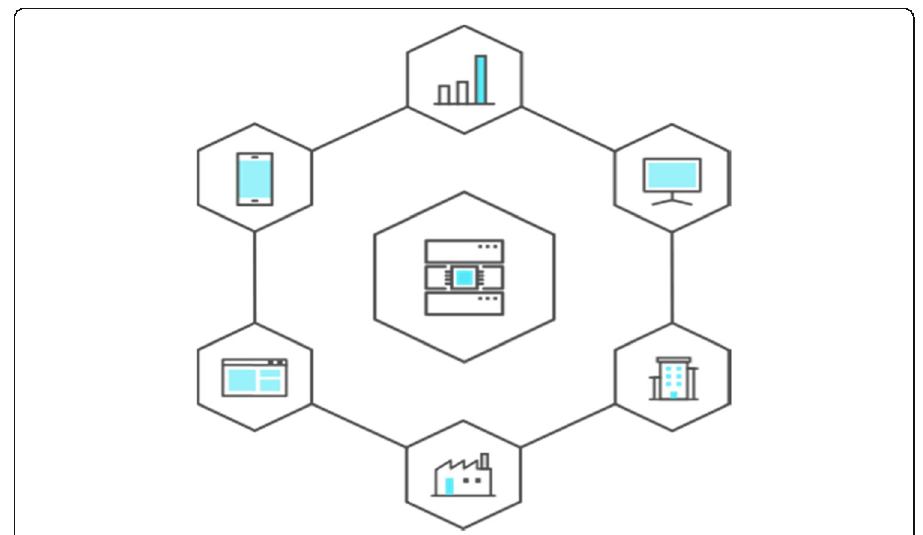
Fig. 2 Design of data intelligence in business